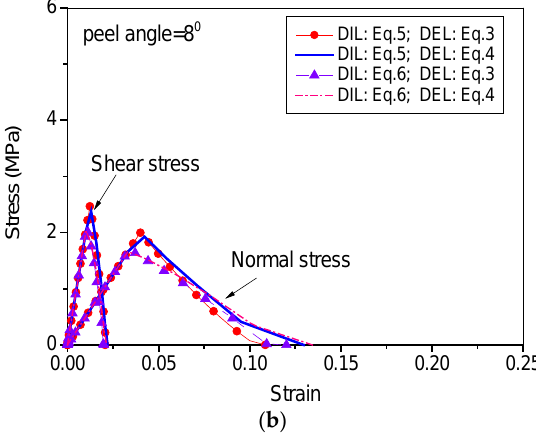
Figure 14. Stress-strain evolutions of the cohesive element under coupled conditions: ( a ) peel angle = 2 degree; ( b ) peel angle = 8 degree.